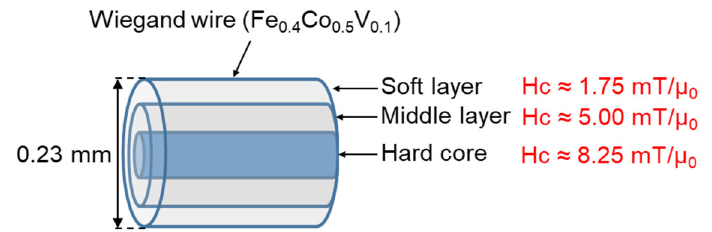
Figure 8. Magnetic structure diagram of Wiegand wire with 0.23 mm diameter.